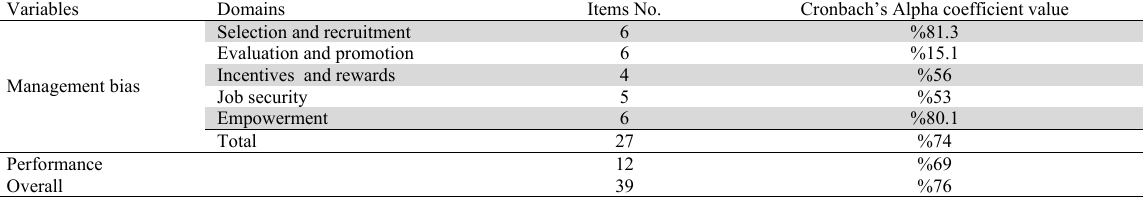
Stability coefficient (Cronbach’s alpha) values of each domain and items number Variables Domains Items